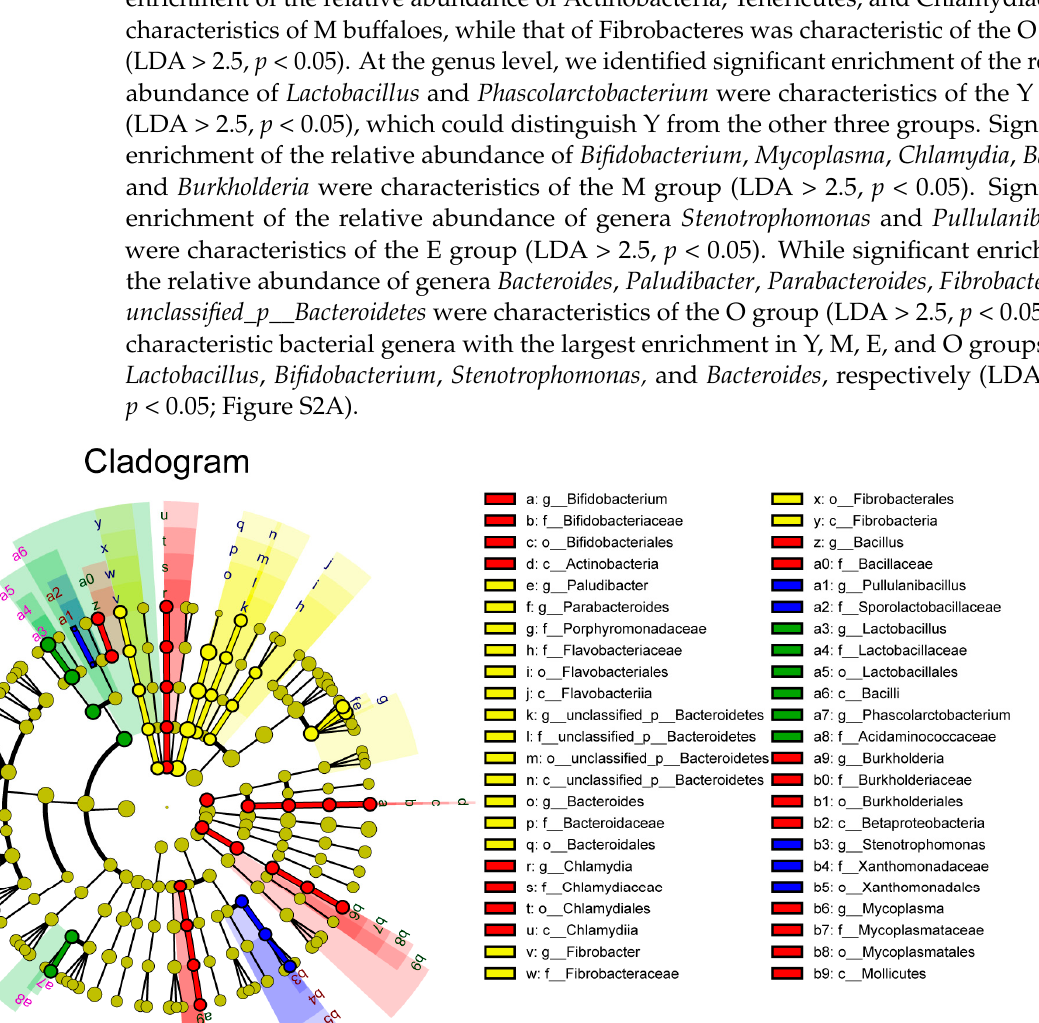
lowest content of Methanobrevibacter (LDA > 3, p < 0.01), while the abundances of other differential genera, including Methanobacterium (Y: 3.09 ± 0.55%; M: 1.05 ± 0.05%; E: 1.24 ± 0.08%; O: 1.16 ± 0.13%), Methanosarcina (Y: 1.99 ± 0.24%; M: 0.94 ± 0.11%; E: 1.71 ± 0.24%; O: 1.18 ± 0.04%) and Methanothermobacter (Y: 1.06 ± 0.27%; M: 0.11 ± 0.01%; E: 0.15 ± 0.04%; O: 0.16 ± 0.04%) were all significantly higher in the rumen of Y dairy buffaloes than other 3 groups (LDA > 3, p < 0.01; Figures 2 and S2B).